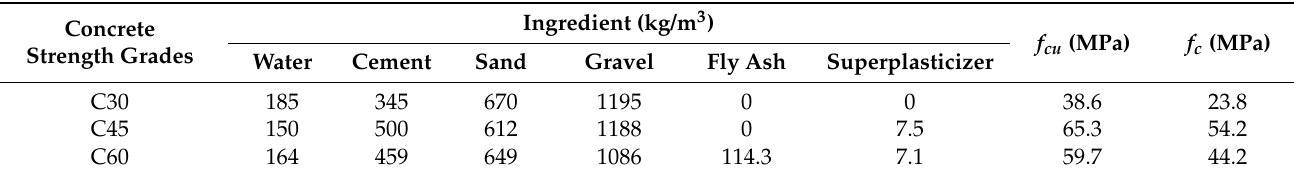
Table 2. Mix proportions and property of